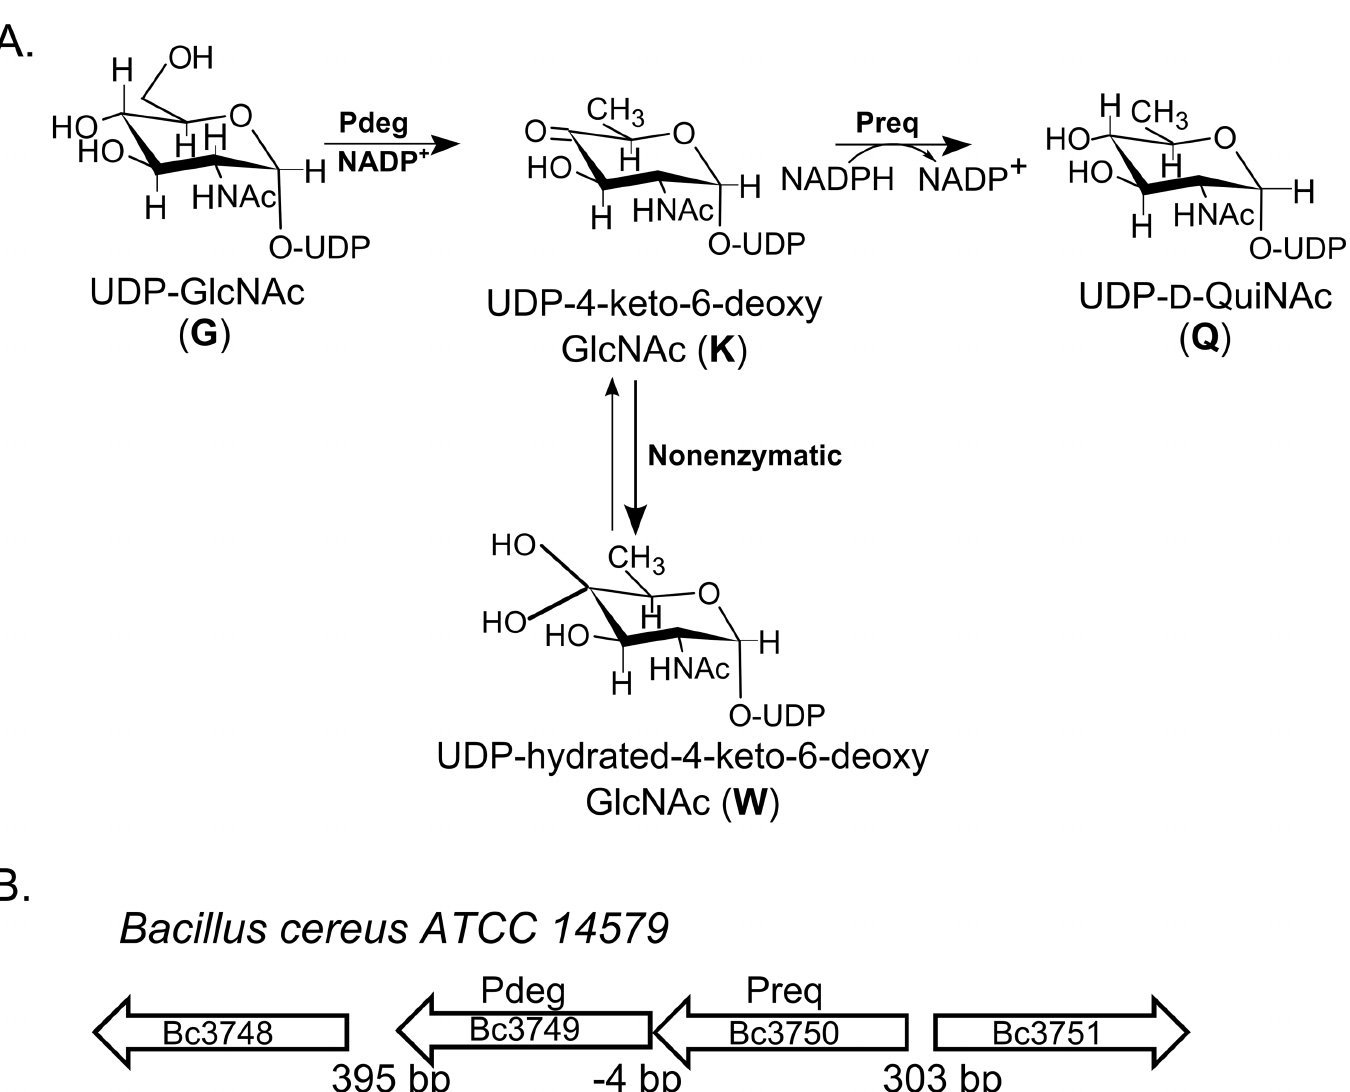
Fig 1. A. A proposed pathway for the formation of UDP-QuiNAc in Bacillus cereus ATCC 14579. The enzyme encoded by Bc3750, UDP-GlcNAc C4,6-dehydratase (Abbr. Pdeg), converts UDP-GlcNAc to UDP-4-keto-6-deoxy-GlcNAc. At steady state, the UDP-4-keto-sugar form (K) is converted non- enzymatically to a hydrated form W. The enzyme encoded by Bc3749 (Abbr. Preq) is a UDP-4-keto-sugar C4 ” -reductase and UDP-D-QuiNAc. B. Organization of the two-genes operon and flanking regions in B. cereus ATCC